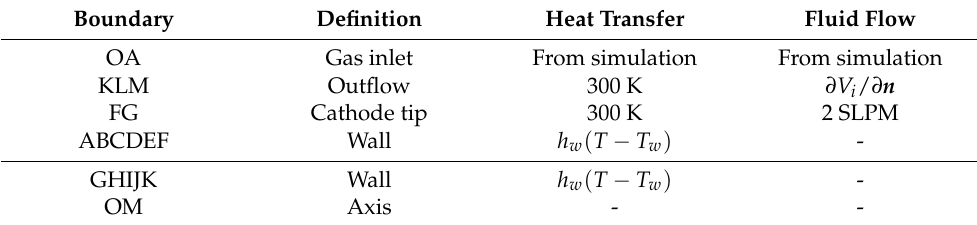
Table 5. Boundary conditions for plasma jet